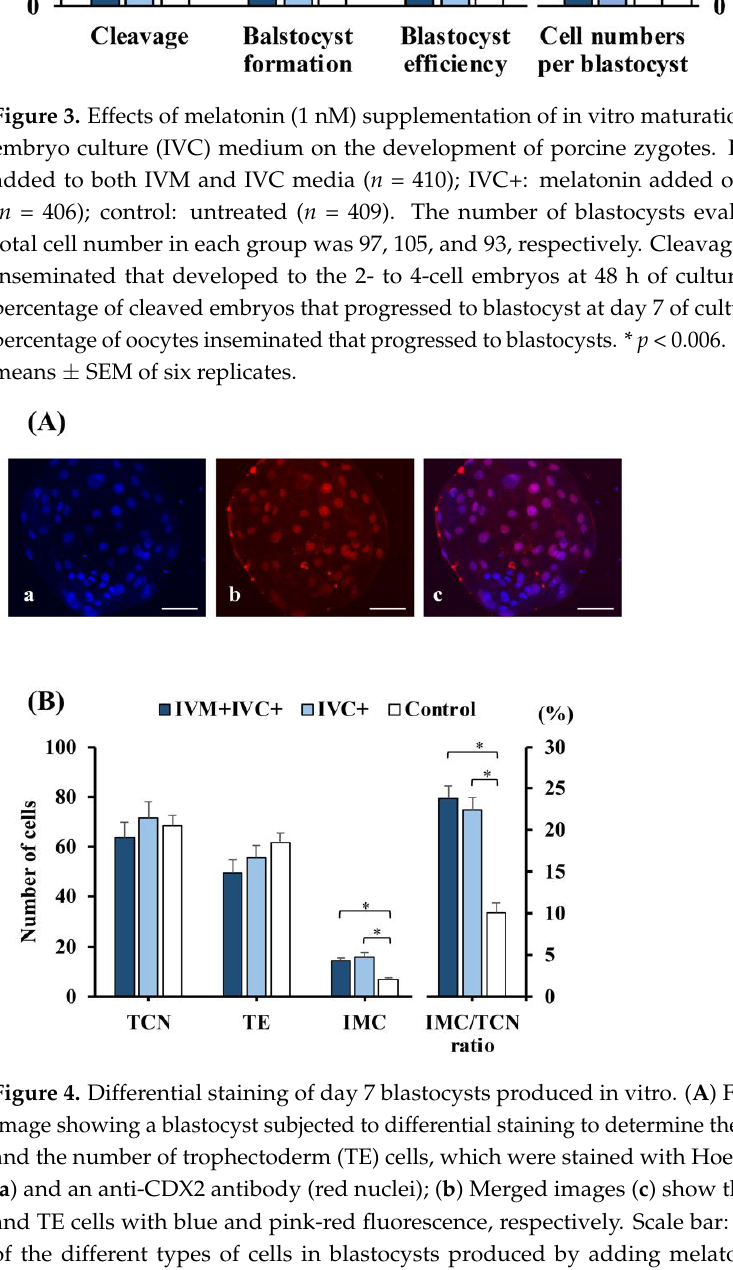
Figure 4. Differential staining of day 7 blastocysts produced in vitro. ( A ) Fluorescence microscopy image showing a blastocyst subjected to differential staining to determine the total cell number (TCN) and the number of trophectoderm (TE) cells, which were stained with Hoechst 33,342 (blue nuclei); ( a ) and an anti-CDX2 antibody (red nuclei); ( b ) Merged images ( c ) show the inner cell mass (ICM) and TE cells with blue and pink-red fluorescence, respectively. Scale bar: 50 µ m. ( B ) Distribution of the different types of cells in blastocysts produced by adding melatonin (1 nM) to both the maturation and culture media (IVM + IVC+ group; n = 14), or only to the culture medium (IVC+ group; n = 15). Blastocysts derived from oocytes that were matured, fertilized, and cultured in media without melatonin supplementation were used as controls ( n = 15). * p < 0.001. Data are presented as the means ± SEM (three